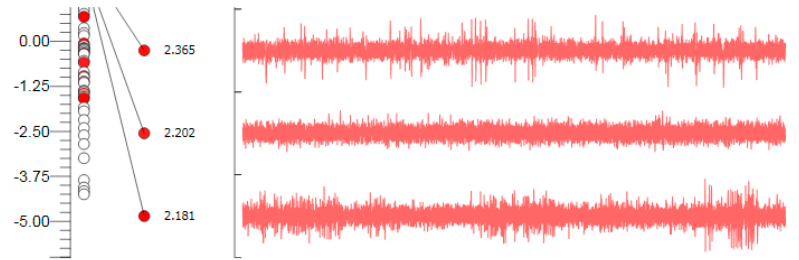
Figure 7. Microelectrode recording appearance of the subthalamic nucleus signal; note the increase in background activity, with high amplitude irregular firing.